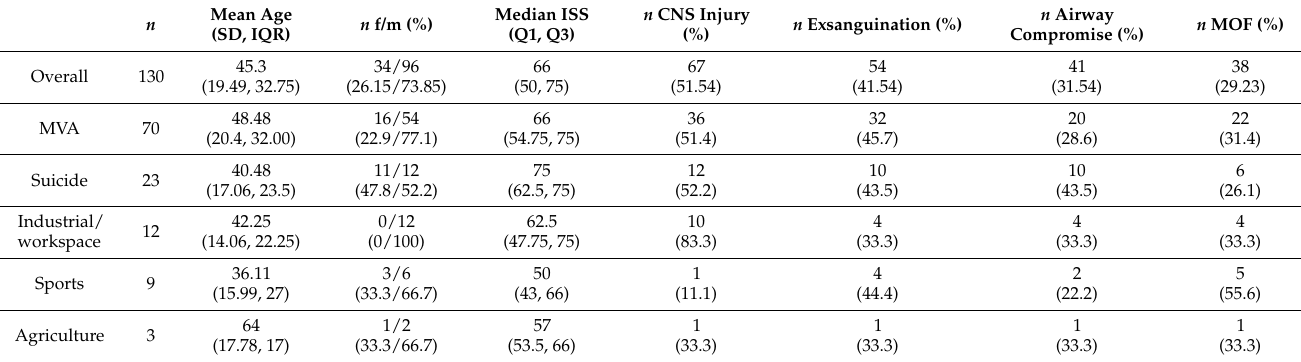
Table 1. Frequencies and numerical summaries of demographic data, trauma mechanisms, and causes of death.